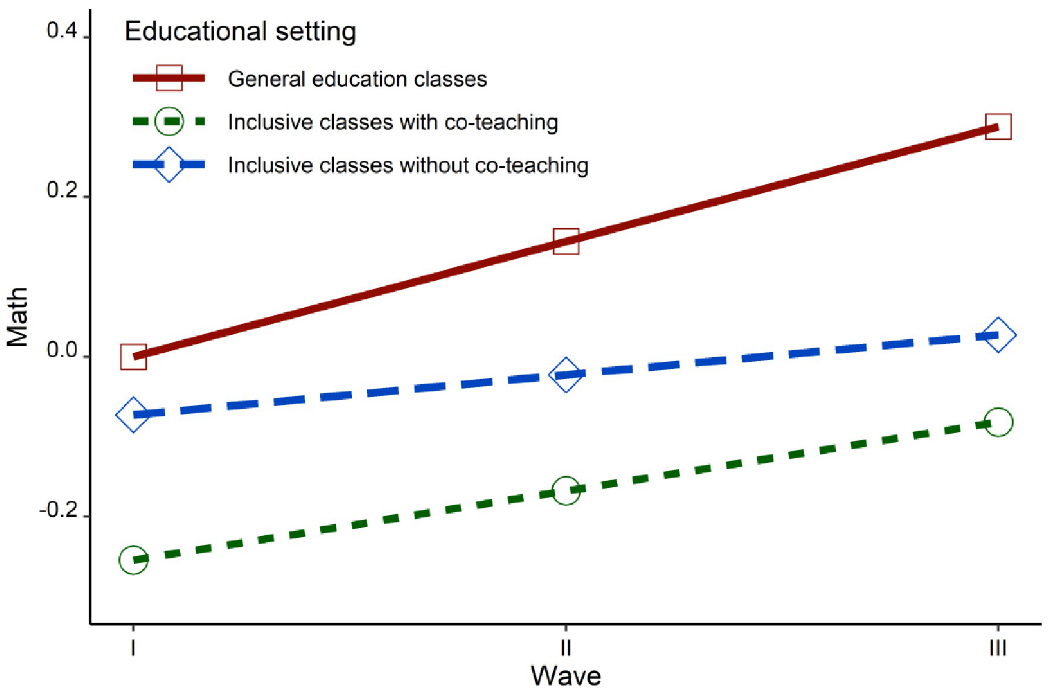
Fig 1. Changes in academic achievement in mathematics across waves and educational